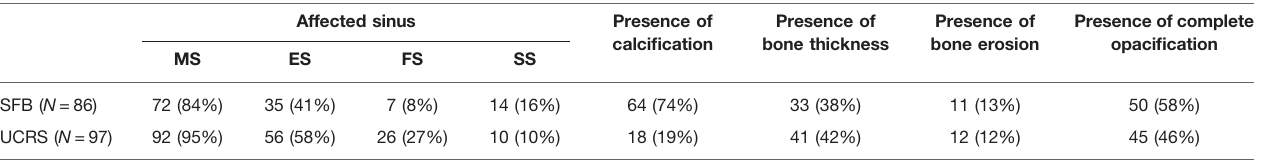
TABLE 2 | CT fi ndings for SFB and UCRS ( N